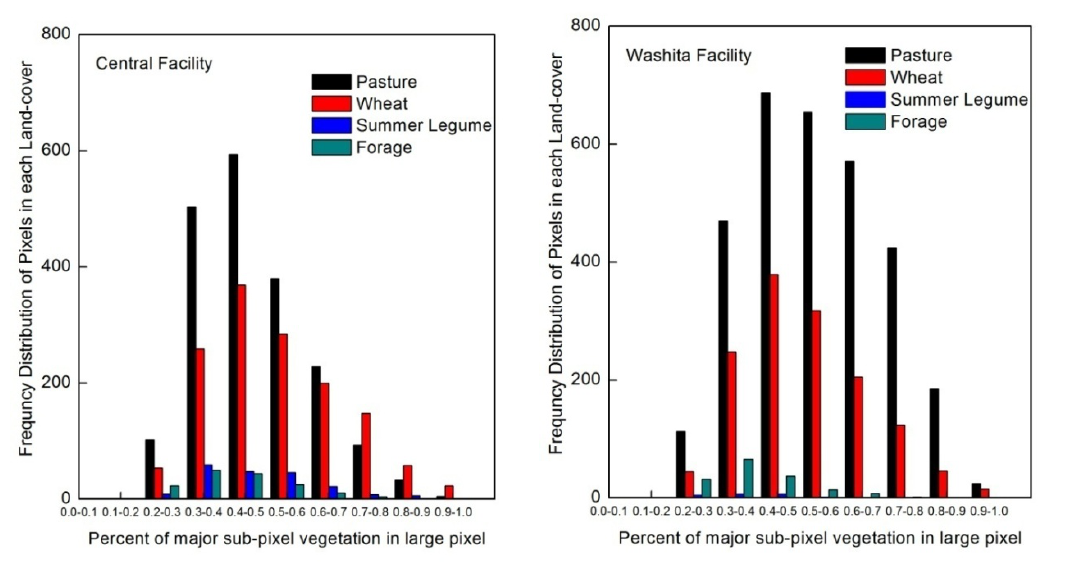
Figure 3. Histograms of sub-pixels (30 m) heterogeneity of land-cover type in ESTAR footprint (800 m) in study area.